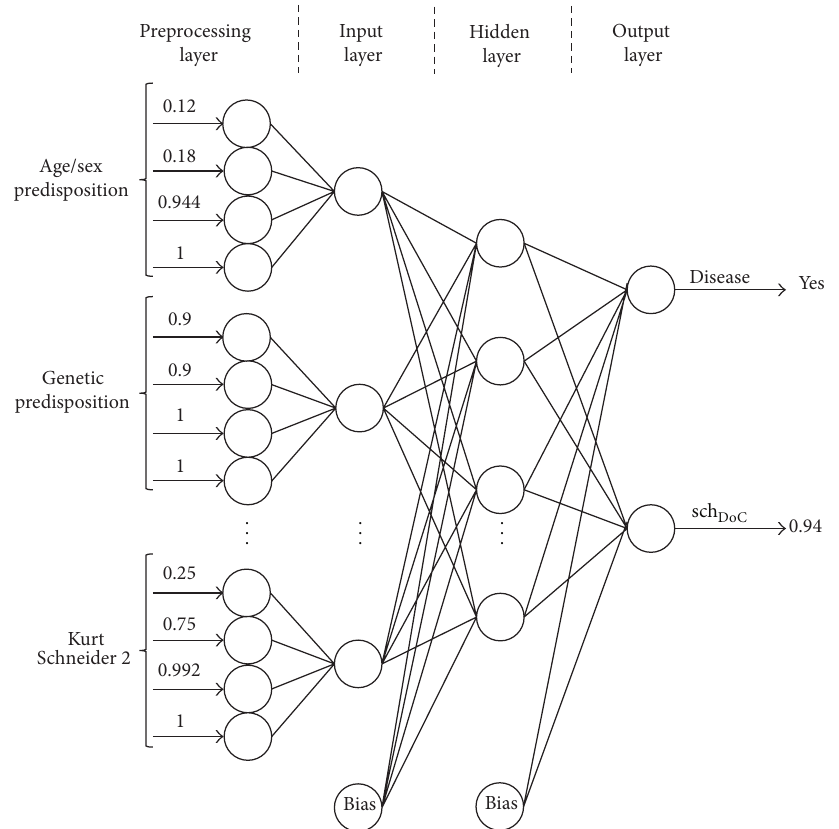
Figure 3: The ANN for the 22-year-old